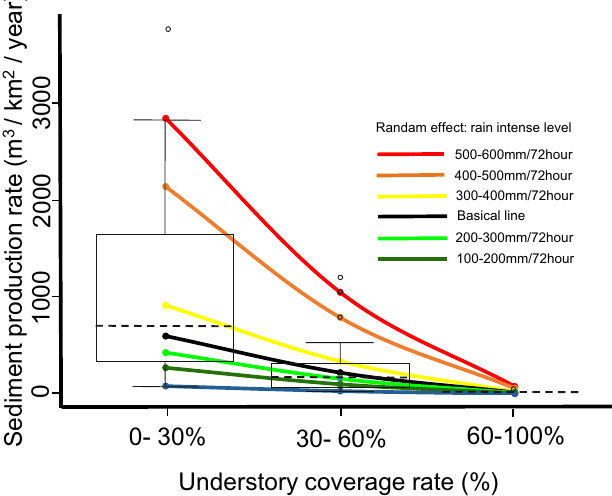
Figure 1. The result of regression analysis about the relationship between sediment production rate and understory coverage rate. The boxplot shows the sediment production per 1 km 2 on the surface of each understory coverage rate of 0–30%, 30–60%, 60–100%. The graph was drawn by T. Mizuno using Microsoft PowerPoint. The boxplot was based on the graphic of the calculated results by R Commander version 2.7–1 25,26 and the line by using the calculated results of the Poisson regression analysis of lme4 package version 1.1–26 21